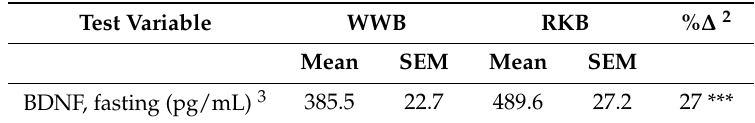
Figure 1. Brain-derived neurotrophic factor (BDNF) concentrations at fasting, 10.5 h post intake of rye kernel-based bread (RKB) or white wheat flour-based bread (WWB) evening meals the mean concentrations of the fasting BDNF in plasma 10.5 h post ingestion of one (1D) or three consecutive (3D) evening meals consisting of rye kernel-based bread (RKB) or white wheat flour-based bread (WWB), respectively. Values are means ± SEM. Table 2. Fasting plasma brain-derived neurotrophic factor (BDNF) concentrations, 10.5 h following the RKB and WWB evening meals 1.